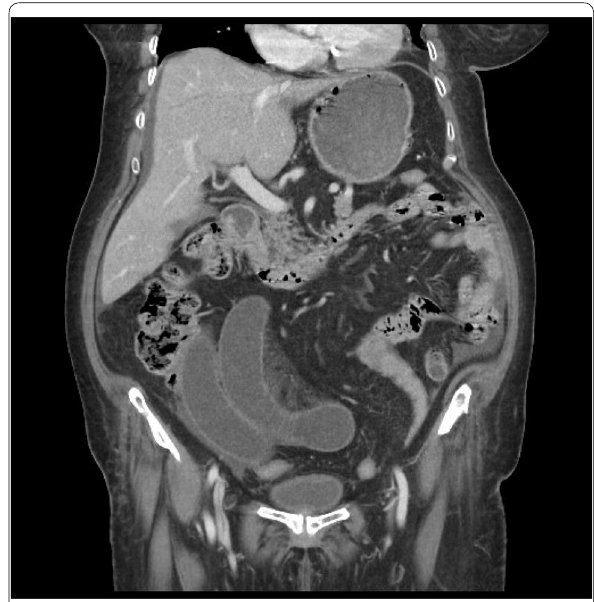
Fig. 4 Point of care ultrasound for acute abdomen showed localized free fluid * with dilated small bowel loop in right lower quadrant with absent peristalsis